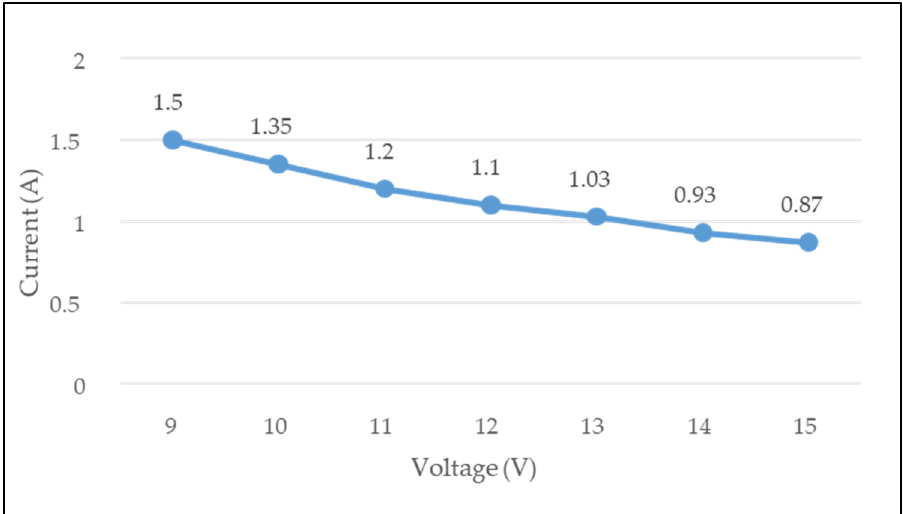
Figure 11. Experimental measurement with a 12 W charger.